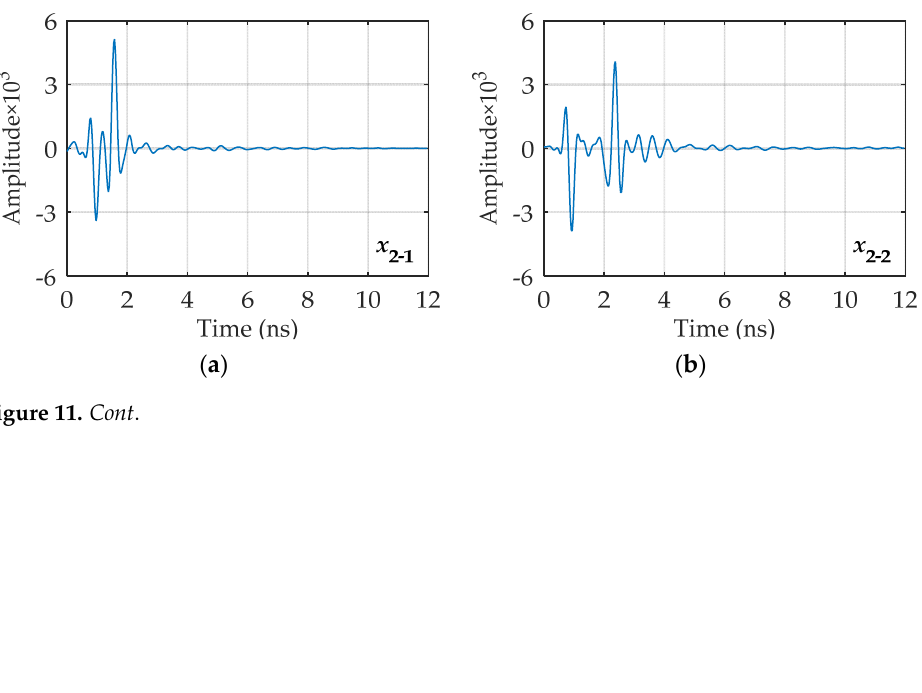
Figure 10. Slice chart formed by twelve horizontal survey lines.